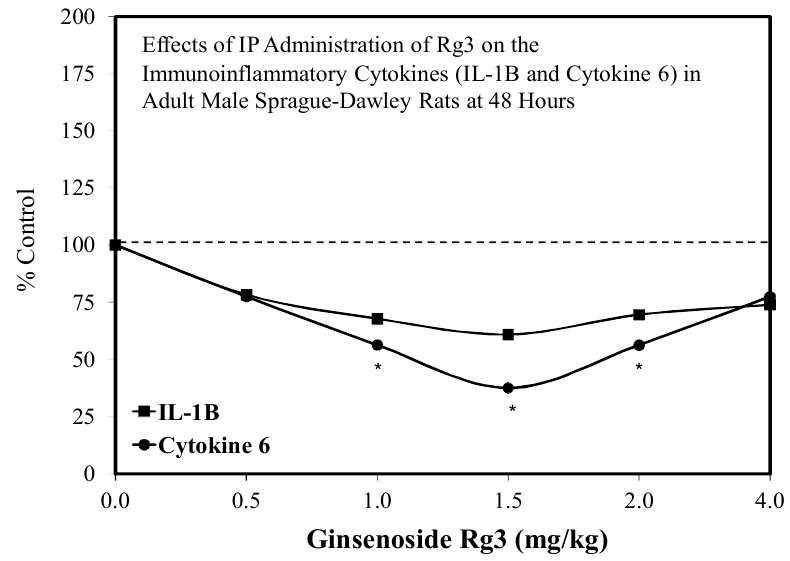
Figure 35. Effects of IP administration of Rg3 on the immunoinflammatory cytokines (IL-1B and cytokine 6) in adult male Sprague–Dawley Rats at 48 hours (source: [113]). Each * represent statistical significance for a data point.